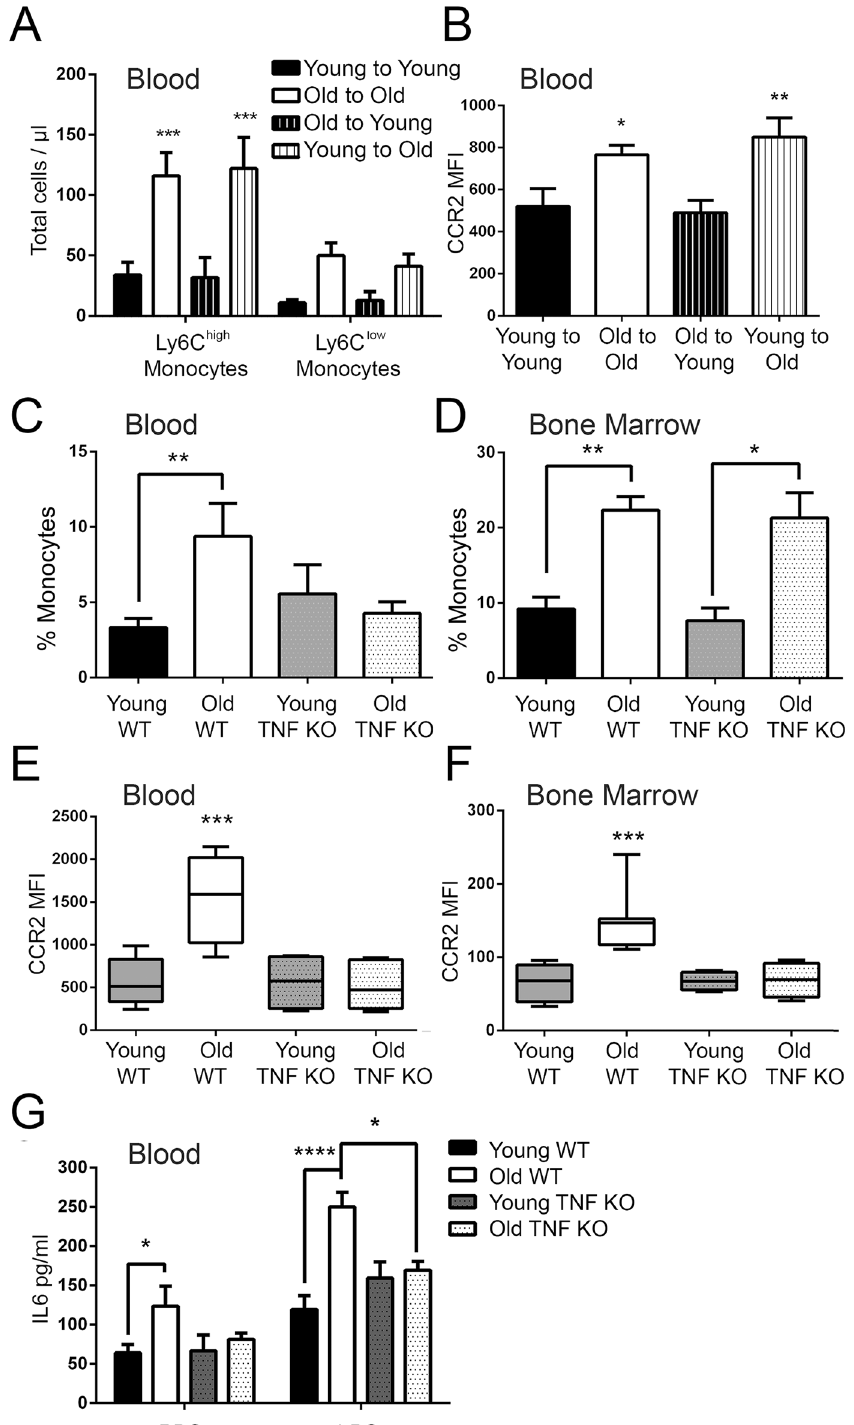
Fig 4. TNF drives increases in circulating Ly6C high monocytes. (A) Total numbers of Ly6C high and Ly6C low monocytes in the blood of heterochronic bone marrow chimeric mice. Old recipient mice which receive young donor marrow have increased numbers of circulating Ly6C high and Ly6C low monocytes which are comparable to old recipient mice that receive old donor marrow. Young recipient mice that receive old donor marrow do not have an increase in Ly6C high and Ly6C low monocytes. The data represent the mean (